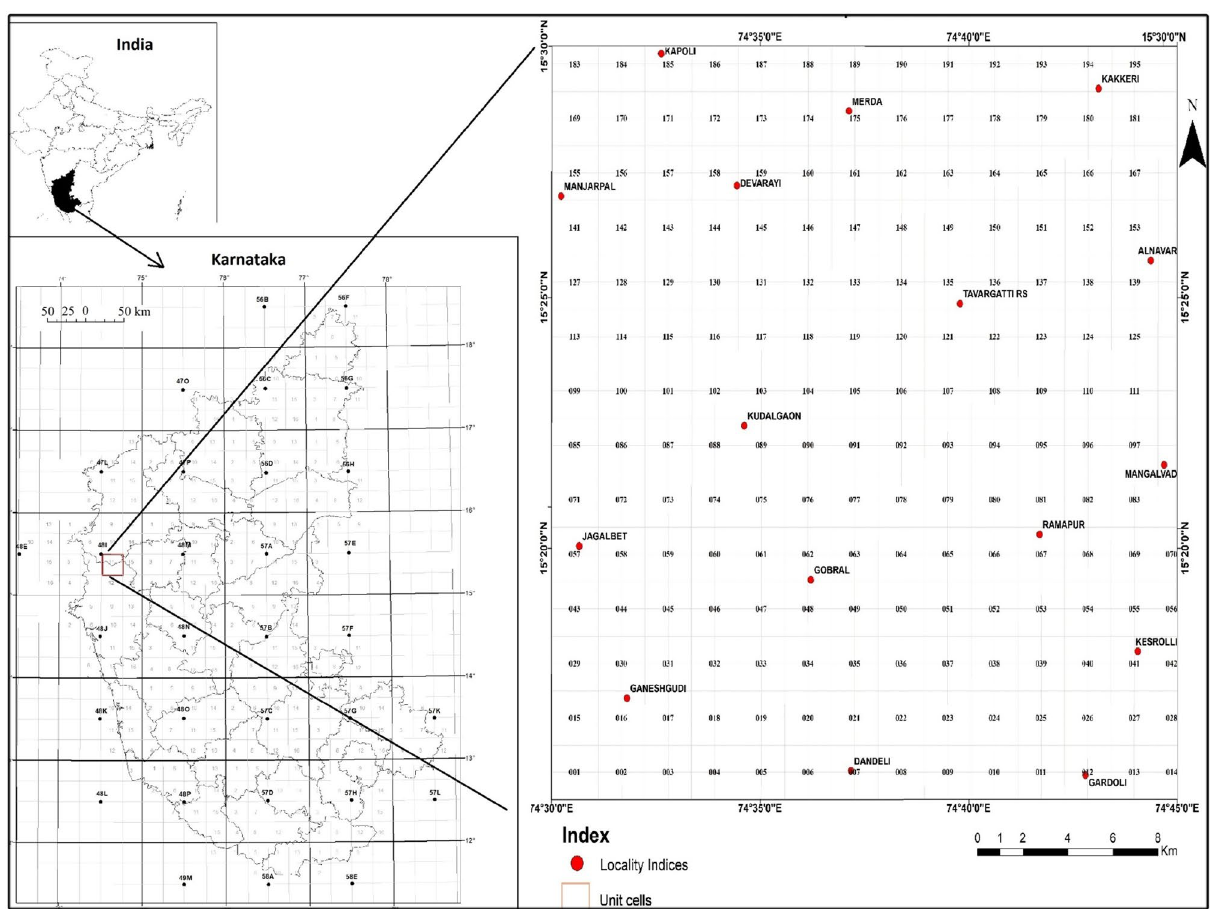
Figure 1. Location map of the study area (Survey of India toposheet no 48I/11) and sampling points. Map prepared using Microsoft Paint and Origin-Pro 2016 software (URL link: http:// www. origi nlab.